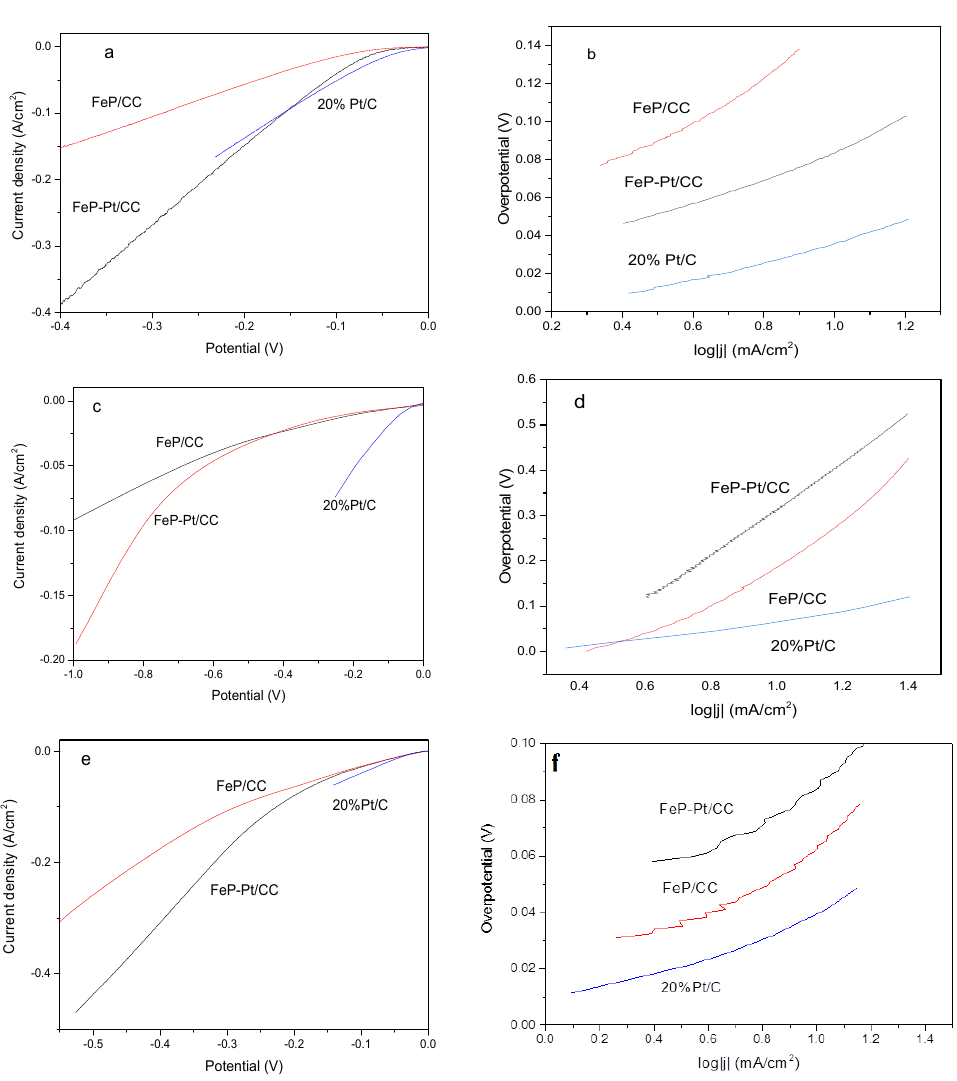
Figure 5. Electrochemical HER measurements. Linear sweep polarization curves obtained in 0.5 M H 2 SO 4 ( a ), 1 M PBS ( c ), 1 M KOH ( e ). The corresponding Tafel slopes ( b , d , f